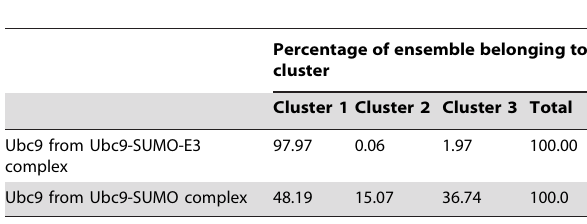
Table 2. Clustering analysis of Ubc9 conformations from the joined